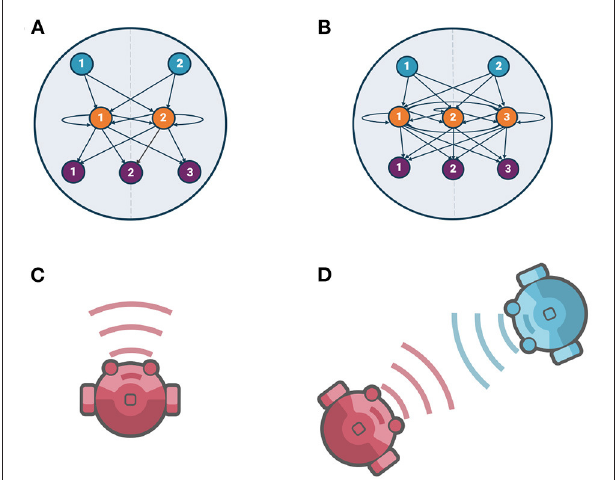
FIGURE 1 | Agents’ neural architecture and evolutionary conditions, (A) 2-neuron model neural architecture, (B) 3-neuron model neural architecture. In both of them, sensor nodes, neurons (fully recurrently connected neurons), and actuator nodes are shown by blue, orange, and purple nodes, respectively. (C) Evolving solitary agents [Individual Evolution (IE)], (D) Evolving interacting pair of agents [Social Evolution (SE)].